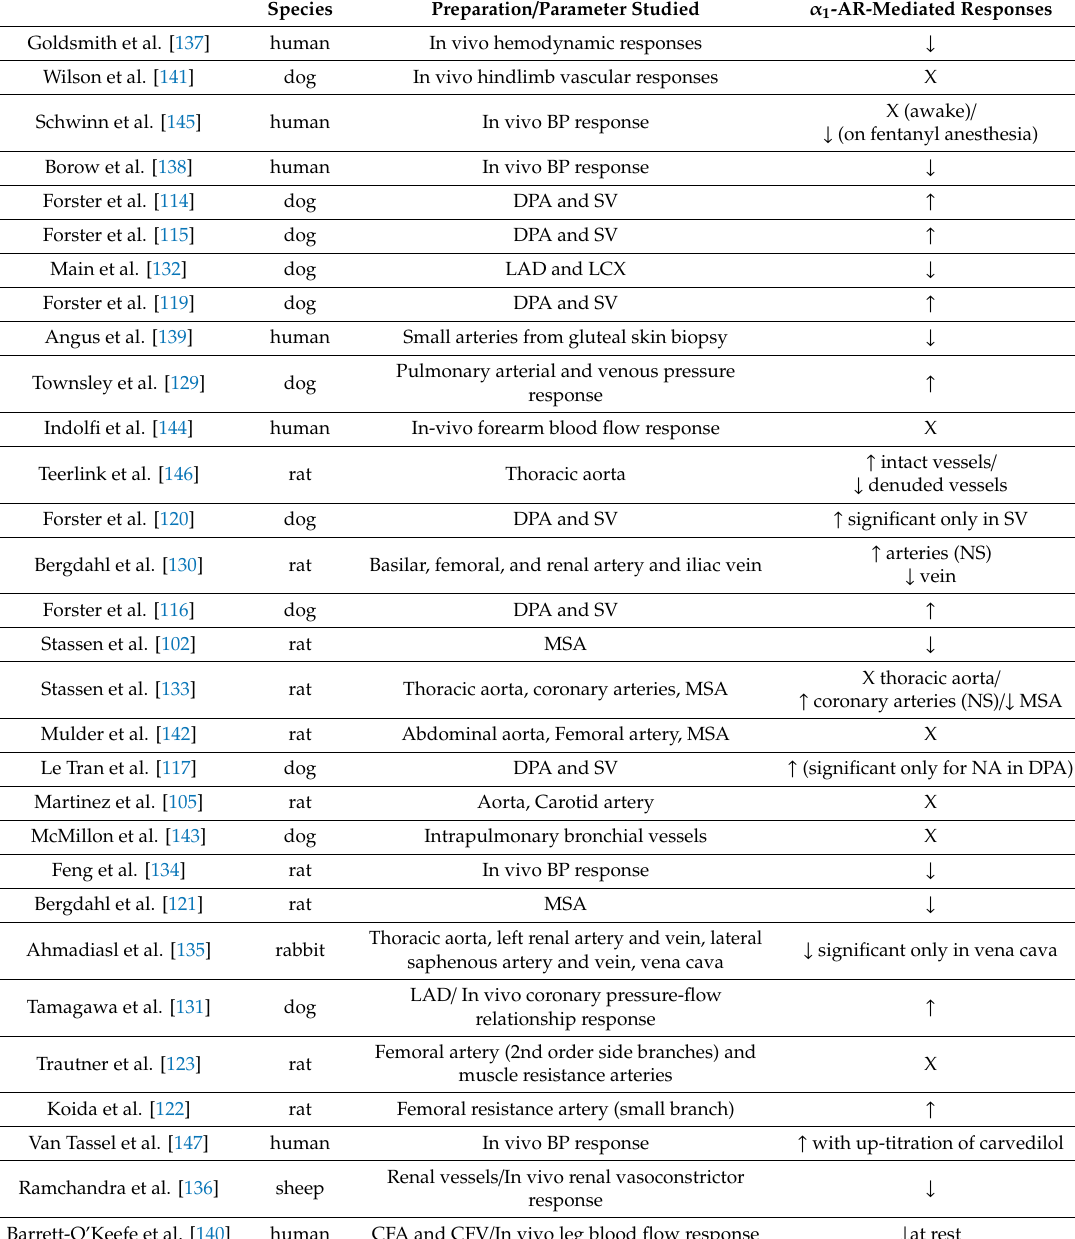
Table 4. Summary of changes in vascular α 1 -adrenoceptor (AR)-mediated responses in chronic heart